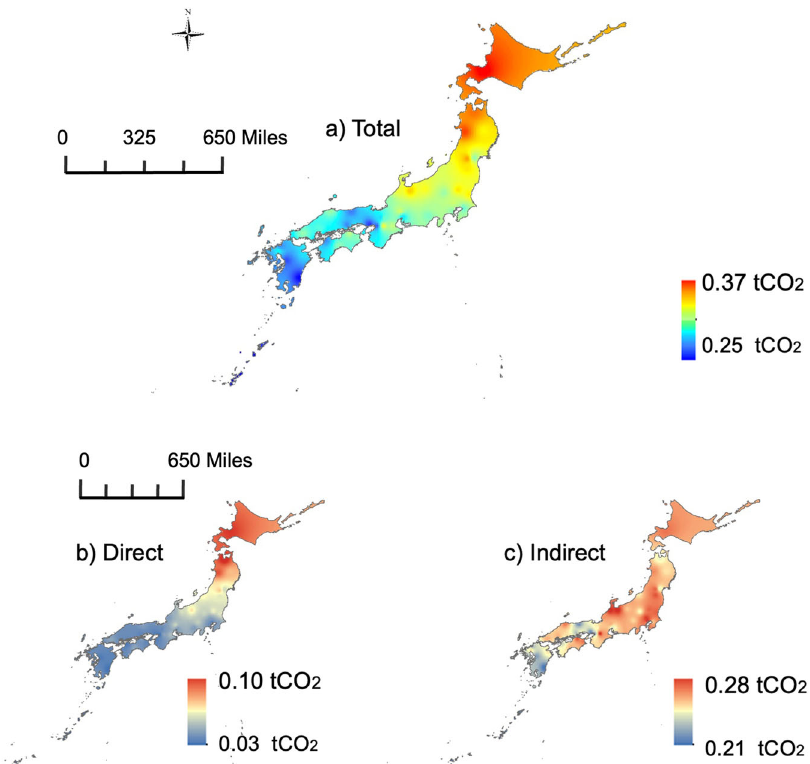
Fig. 2 Interpolation results of the distribution of household carbon footprint in Japanese cities. a Total, b Direct, and c Indirect carbon footprints (in tCO 2